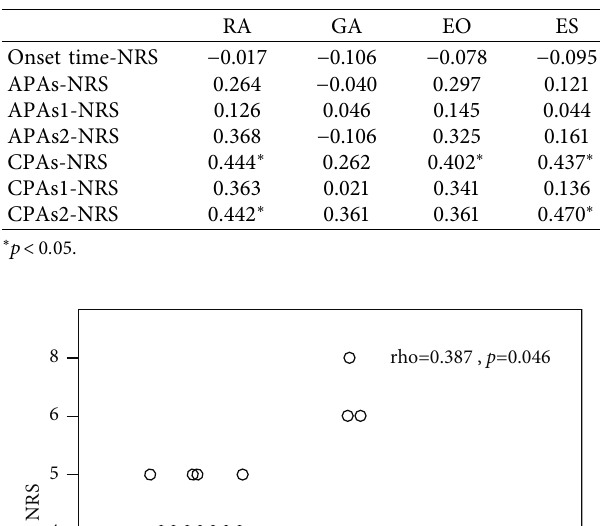
Table 7: Spearman’s correlation analysis between NRS scores and muscle onset time/iEMGs in the internal perturbation task.